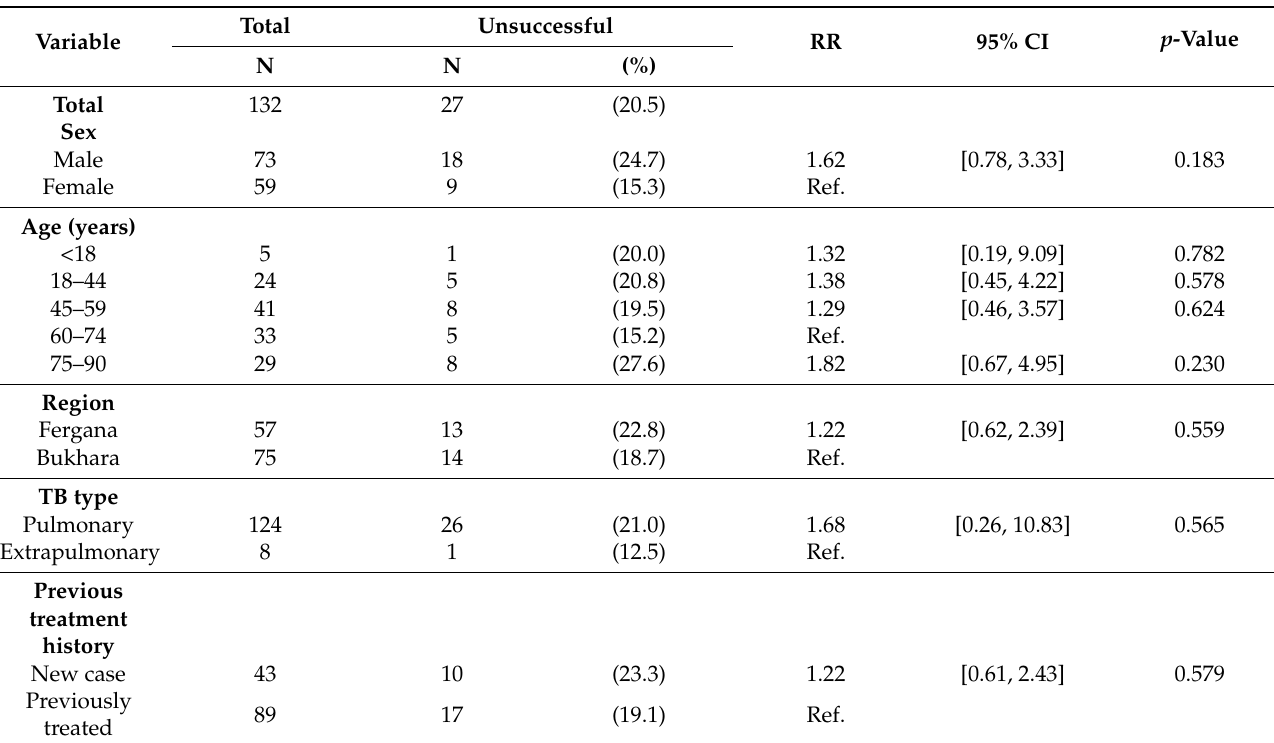
Table 3. Factors associated with unsuccessful outcomes among Hr-TB patients treated in two regions of Uzbekistan from January 2017 to December